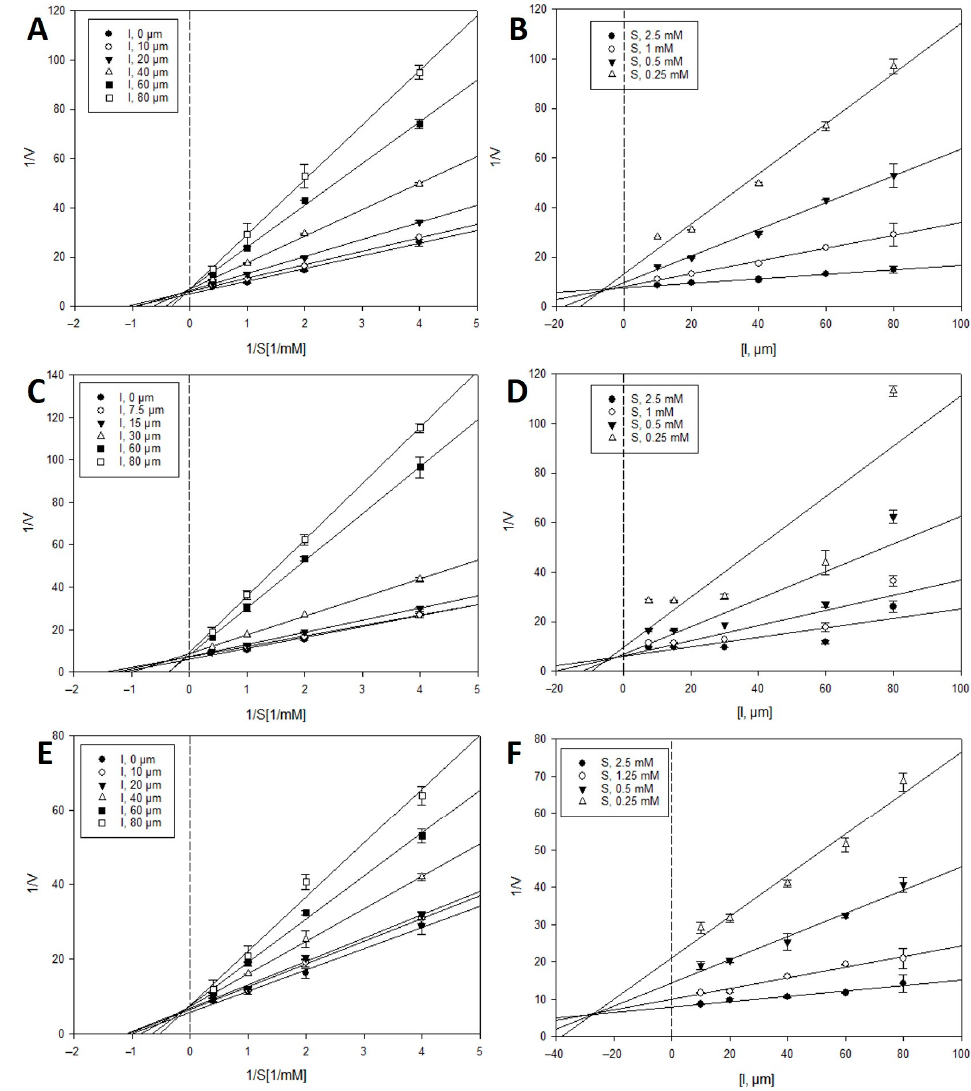
Figure 3. Lineweaver–Burk plots ( A , C , E ) and Dixon plots ( B , D , F ) for the β -glucuronidase inhibition of dimeric phloroglucinols 13 – 15 , respectively.